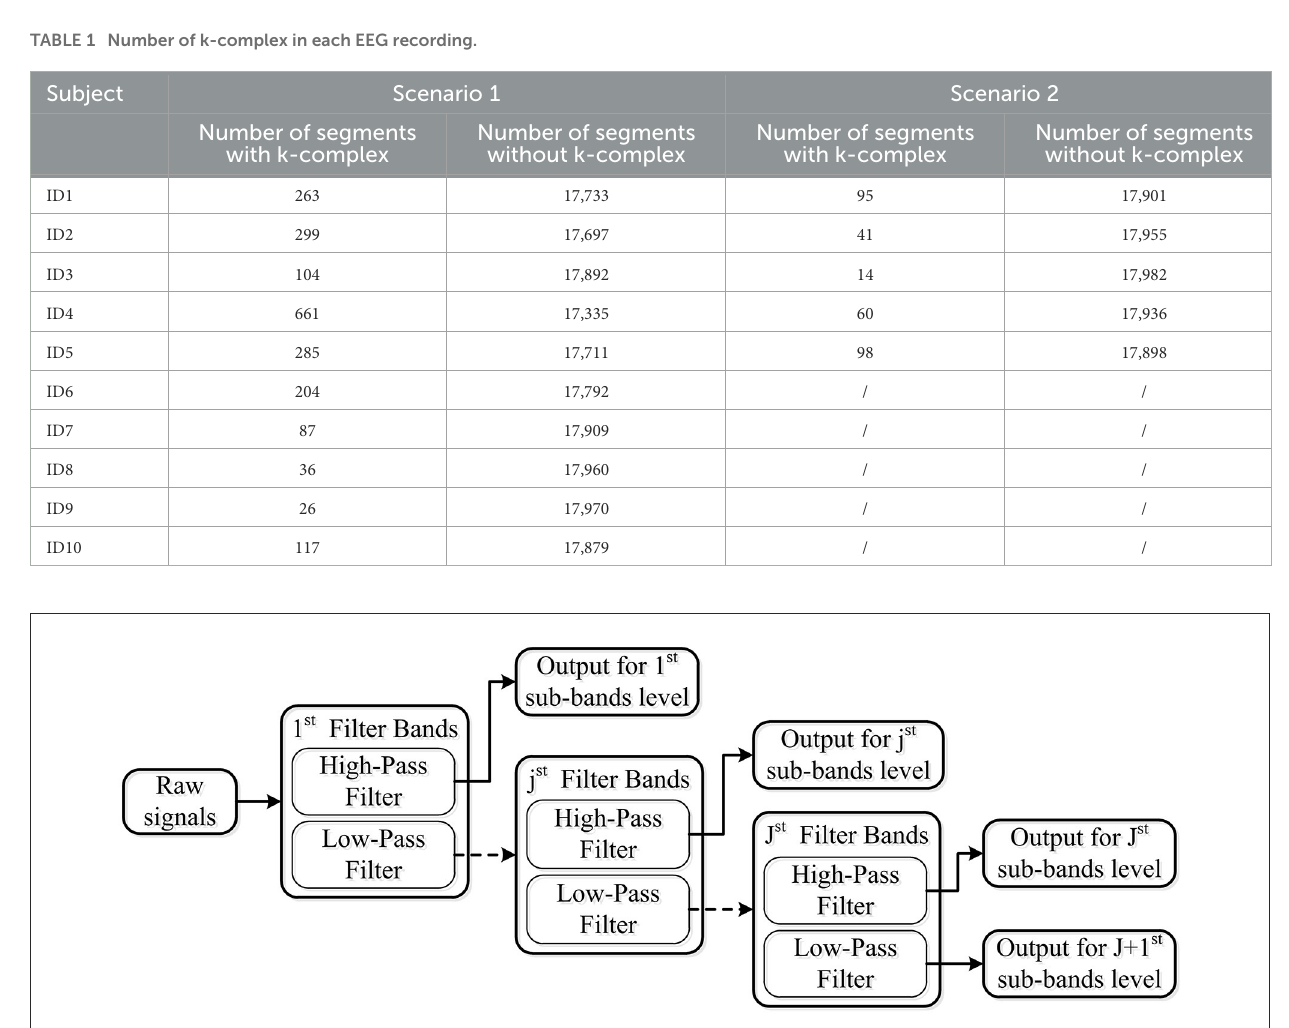
components. Meanwhile, the decomposing waveform based on a lower Q-factor is suitable for extracting the features of the transient